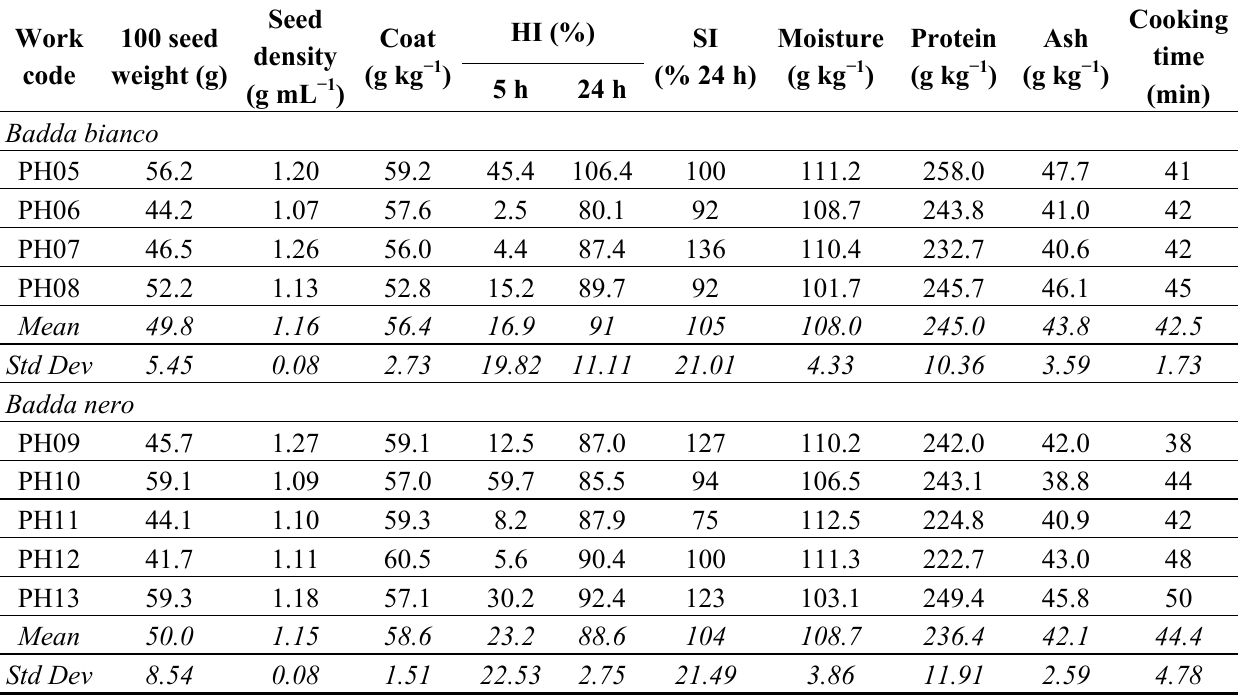
Table 5. Grain quality traits. Seed composition values are referred to dry